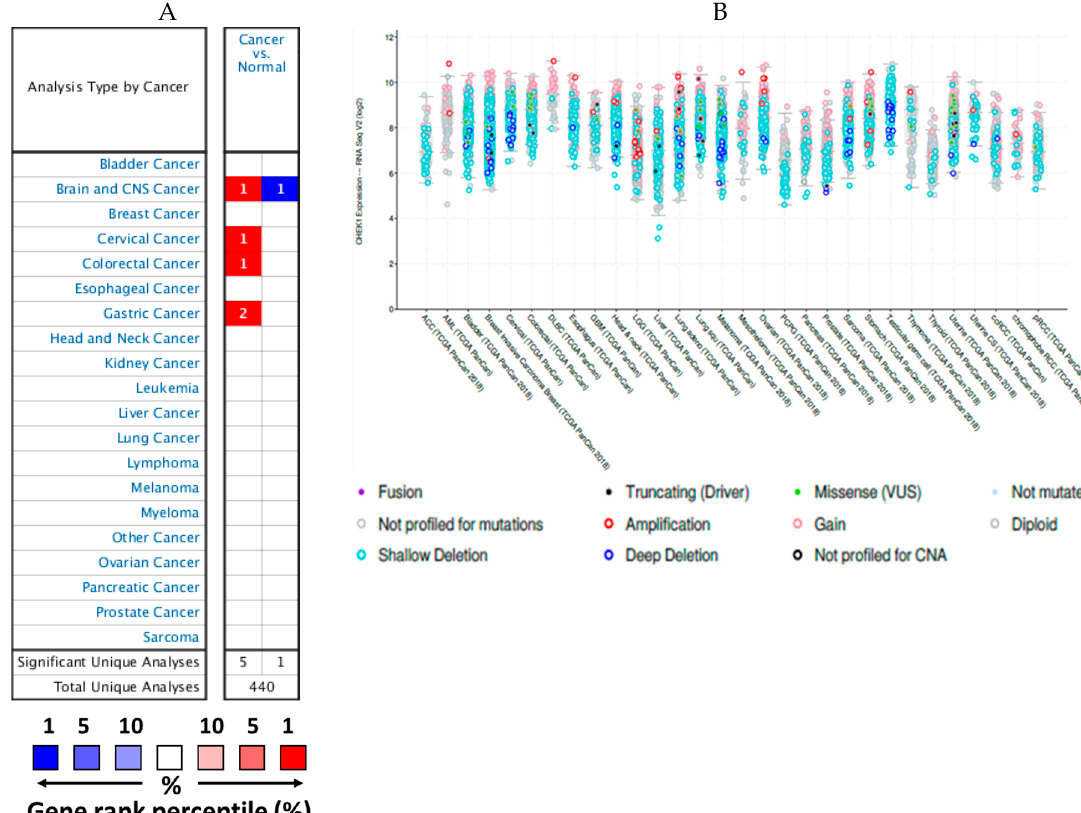
Figure 1. The expression levels of CHEK1 in di ff erent types of solid tumors (Oncomine database and cBioPortal). ( A ) This plot indicates the numbers of datasets with statistically significant (p < 0.01) mRNA over-expression (red) or down-expression (blue) of CHEK1 (di ff erent types of cancer vs. corresponding normal tissue). The threshold was designed with the following parameters: p-value of 1.0 × 10 − 8, 2 × fold change, and gene ranking of 1%. ( B ) Analysis of CHEK1 mRNA levels in 30 types of human cancers. The median and interquartile ranges are shown in each box.